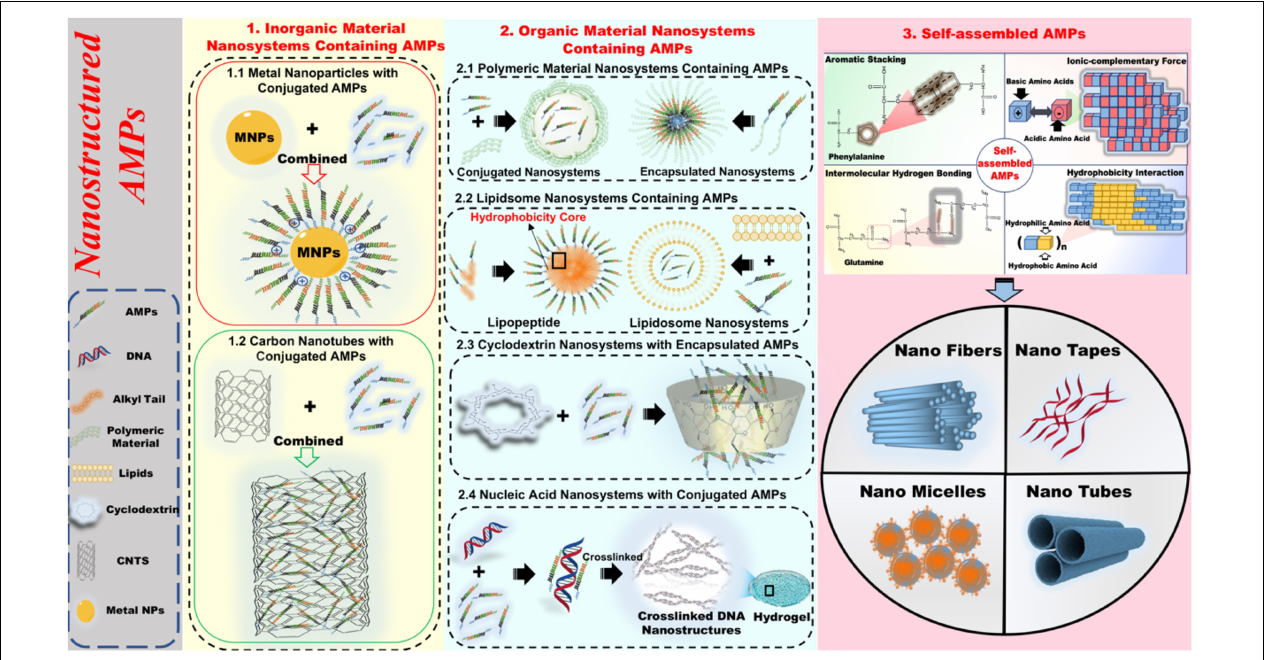
FIGURE 2 | The specific classification and description of nanostructured antimicrobial peptide (Ns-AMPs). The Ns-AMPs could be classified into inorganic material nanosystems containing AMPs, organic material nanosystems containing AMPs, and self-assembled AMPs. Among them, the inorganic material nanosystems containing AMPs also can be classified into metal nanoparticles with conjugated AMPs and carbon nanotubes with conjugated AMPs. The organic material nanosystems containing AMPs can be divided into polymeric material nanosystems containing AMPs, liposome nanosystems containing AMPs, cyclodextrin nanosystems with encapsulated AMPs, and nucleic acid nanosystems with conjugated AMPs. The self-assembled AMPs could be classified into aromatic stacking, ionic-complementary force, intermolecular hydrogen bonding, hydrophobicity